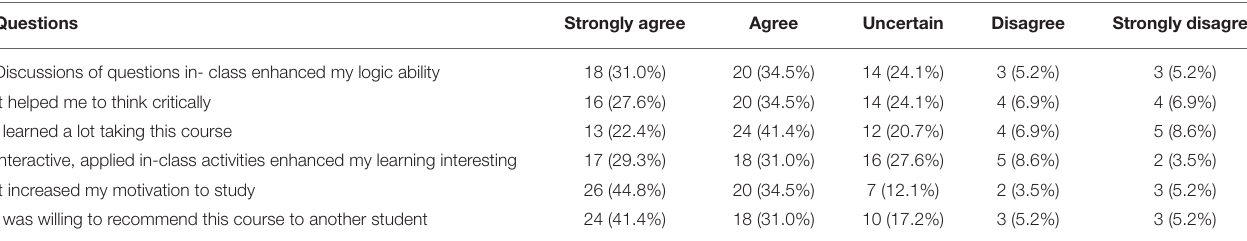
TABLE 1 | Students’ perceptions of flipped classroom teaching in physiology ( n =